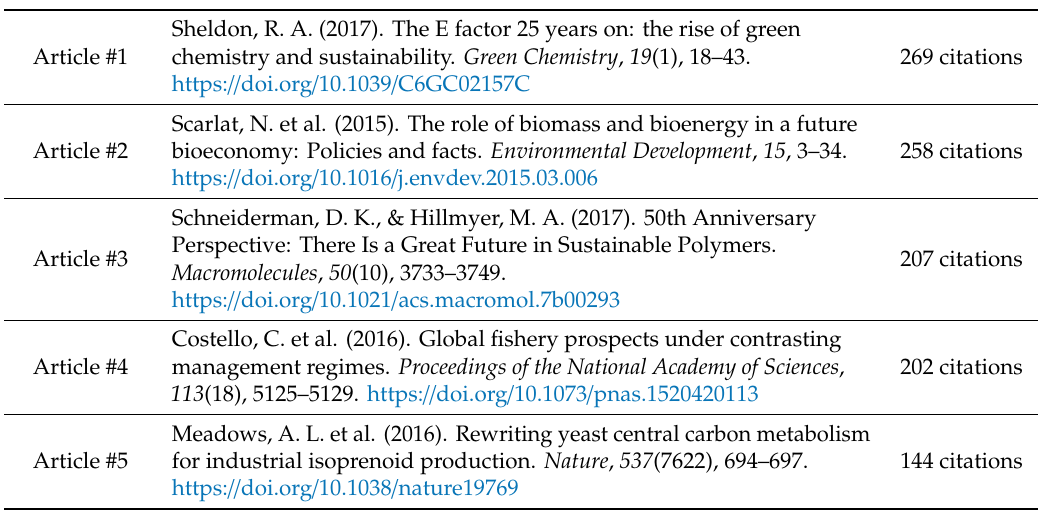
Table 1. Number of citations received by the five most cited articles.